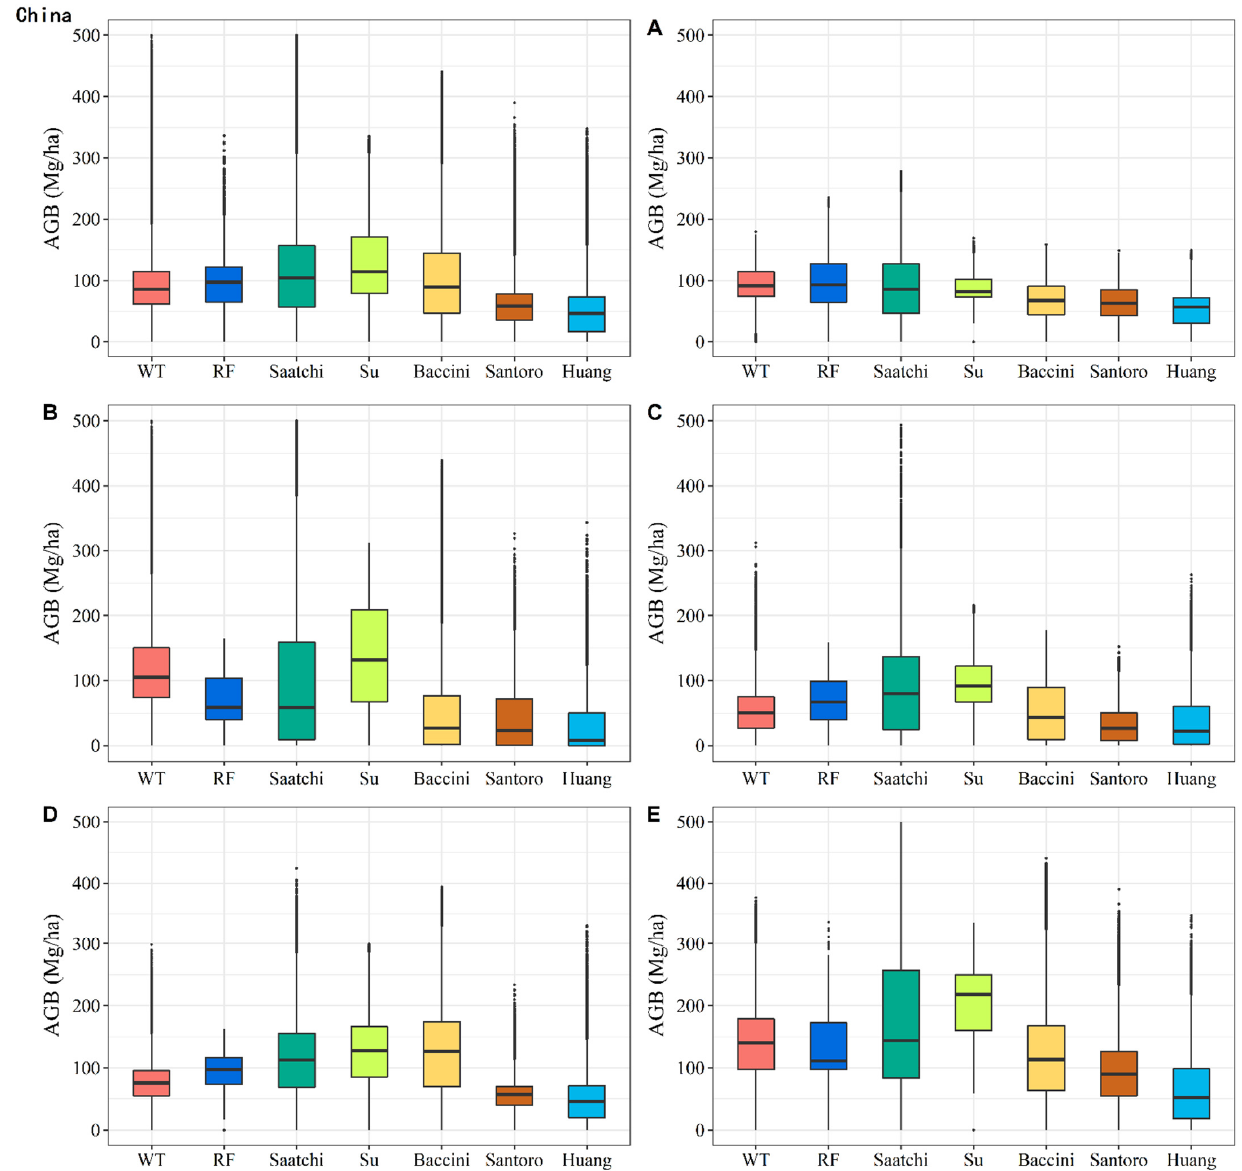
Figure 7. Boxplots displaying the variation of AGB density in China (China) and in each of the five regions ( A – E ) from the WT, RF, Saatchi, Su, Baccini, Santoro, and Huang maps. Table 2. Mean AGB ± one standard error in Mg/ha computed for the hybrid AGB maps (i.e., derived by RF and WT) and each of the Saatchi, Su, Baccini, Santoro, and Huang maps.